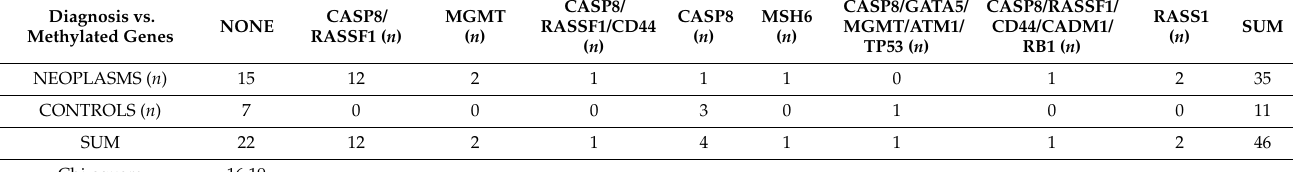
Table 3. Relations of methylated genes with respect to sampling. The data represents the number ( n ) of samples found to be methylated in each subcategory (genes separated with ‘/’ imply the simultaneous methylation of all genes). In particular, we have investigated the relation of methylation with respect to diagnosis and tumor grading. The table depicts the number of samples found to have their promoter methylated with respect to their diagnosis, i.e., between (a) neoplasms and controls; (b) malignant, benign, and control tissues; (c) medulloblastoma, astrocytoma, ATRT, ependymoma, and controls; and (d) tumor